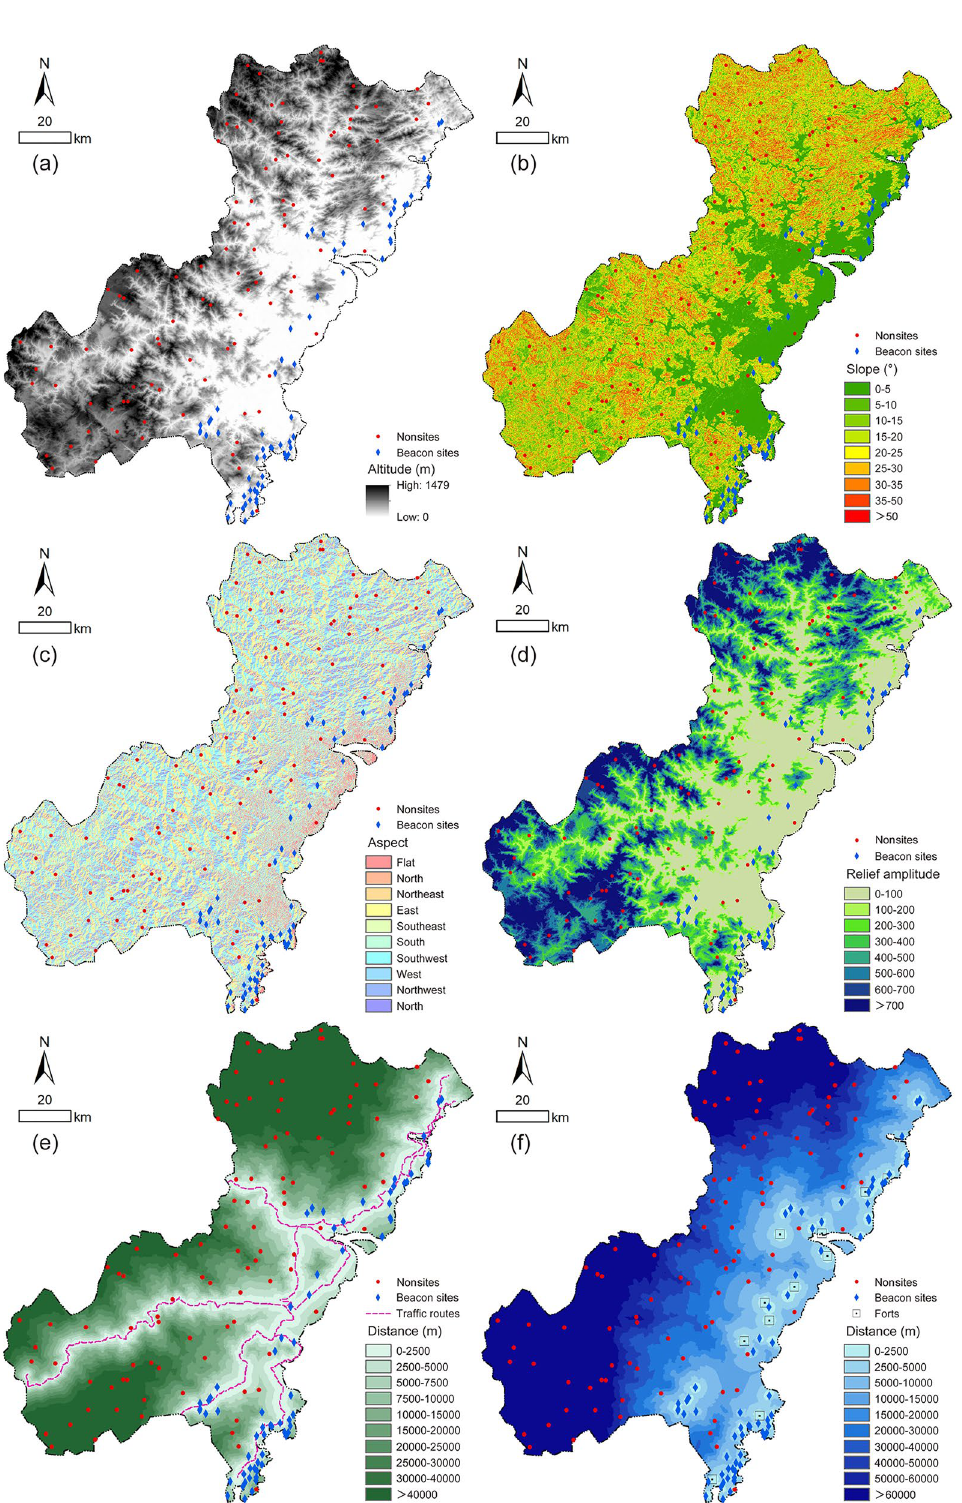
Figure 3. Raster data of alternative independent variables: ( a ) altitude; ( b ) slope; ( c ) aspect; ( d ) topographic relief; ( e ) distance from traffic routes; ( f ) distance from nearest beacon tower or fort (generated by the authors using ArcGIS